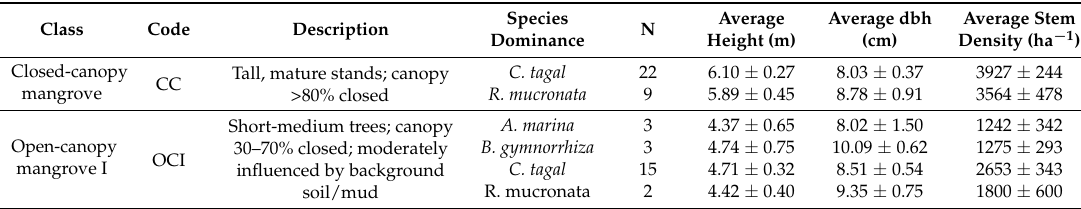
Table 3. Mangrove class, species dominance, average tree height ± standard error (SE) (m), average diameter at breast height (dbh) ± SE (cm), and average trees per hectare ± SE (ha) for mapped and inventoried mangrove classes.